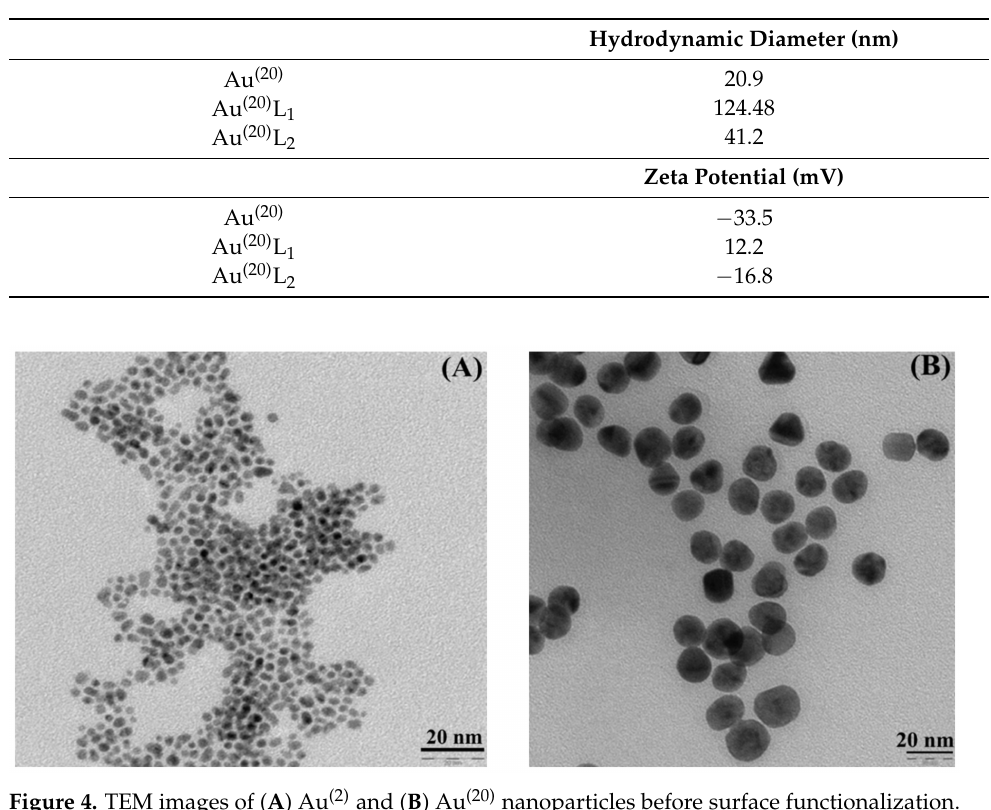
Figure 4. TEM images of ( A ) Au (2) and ( B ) Au (20) nanoparticles before surface